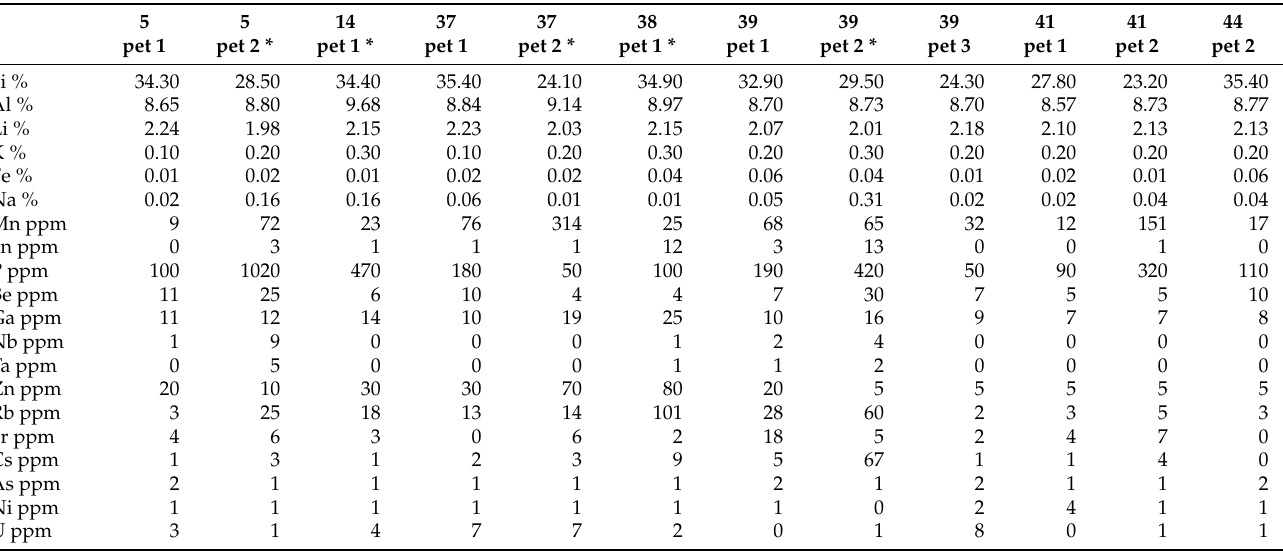
Table 2. Petalite (pet) chemical results from the ICP-MS (inductively coupled plasma mass spectrom- etry) used on the “ Pet_Barroso ” and “ Fe_Barroso ” calibrations of the portable LIBS (laser-induced breakdown